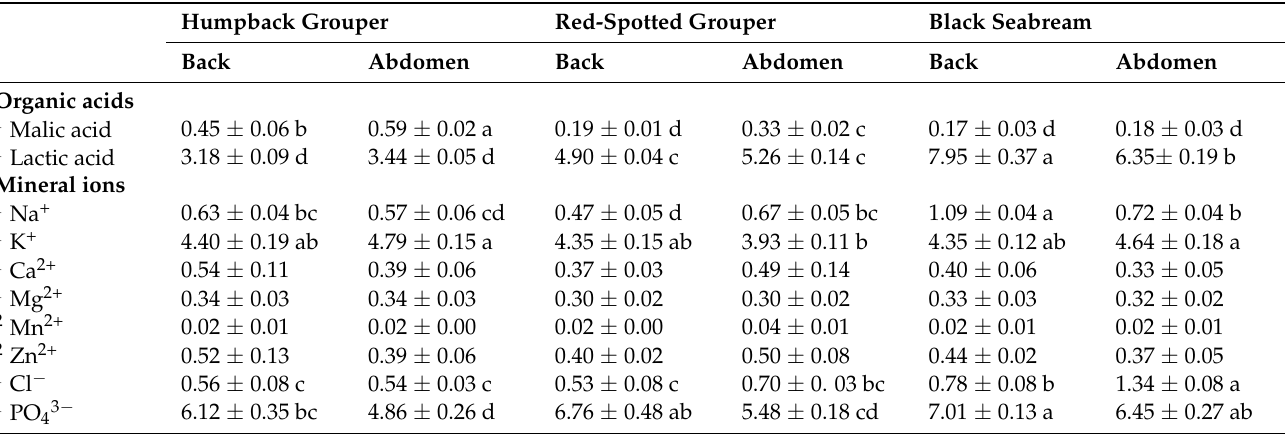
Table 5. The concentrations of organic acids and mineral ions of back and abdominal muscles in three perciform